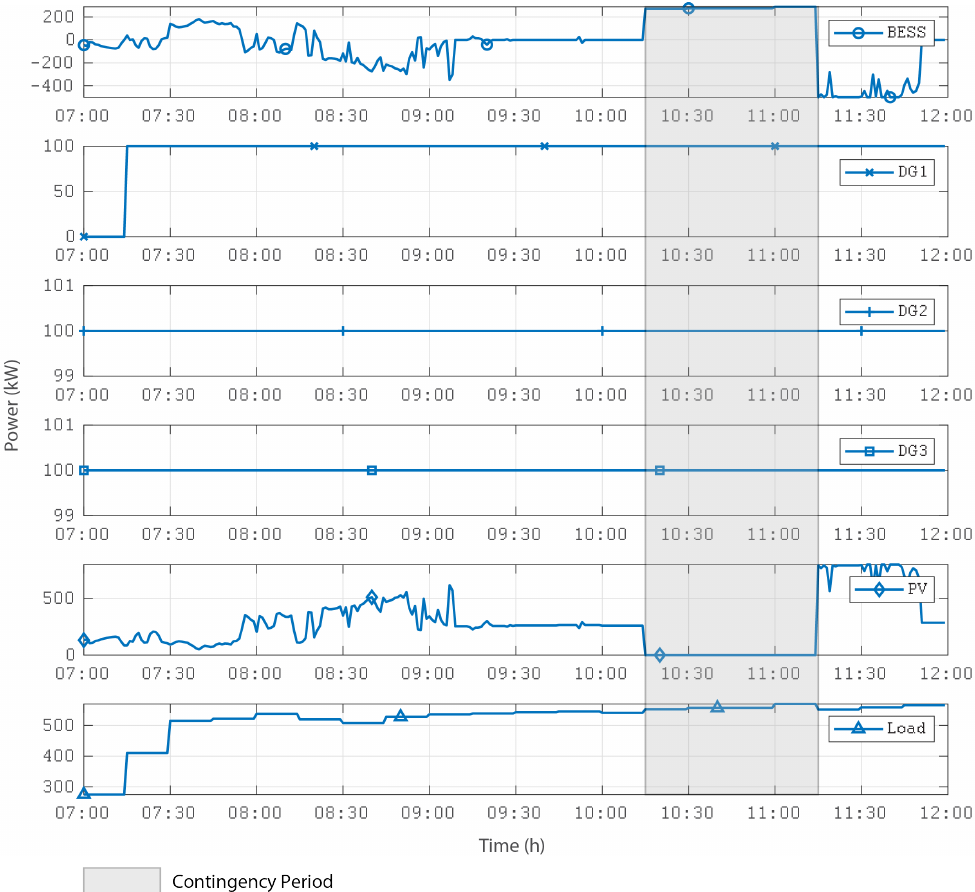
Figure 13. DERs generation and ASC load curves for off-grid operation—case with PV source